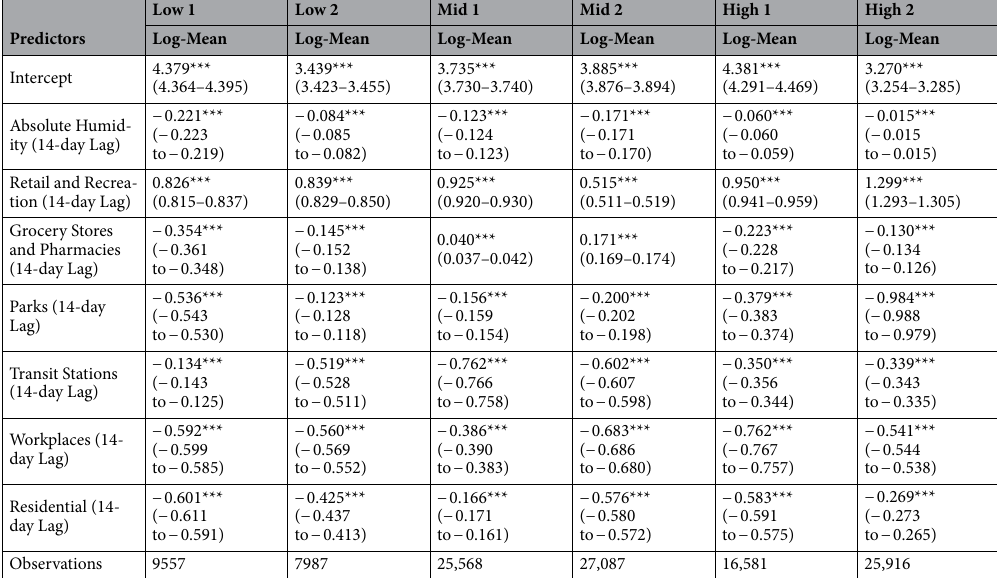
Table 1. Untransformed GLM coefficient estimates for the entire study period. Untransformed coefficient ( β ) estimates for GLM Regression against new cases per 100,000 from March 10, 2020 to March 1, 2021. The 95% confidence intervals are shown in parenthesis. Estimated coefficients for county-level fixed effects and epidemiological terms (immunity factor and lagged daily cases) are not shown. * p < 0.05 ** p < 0.01 *** p <